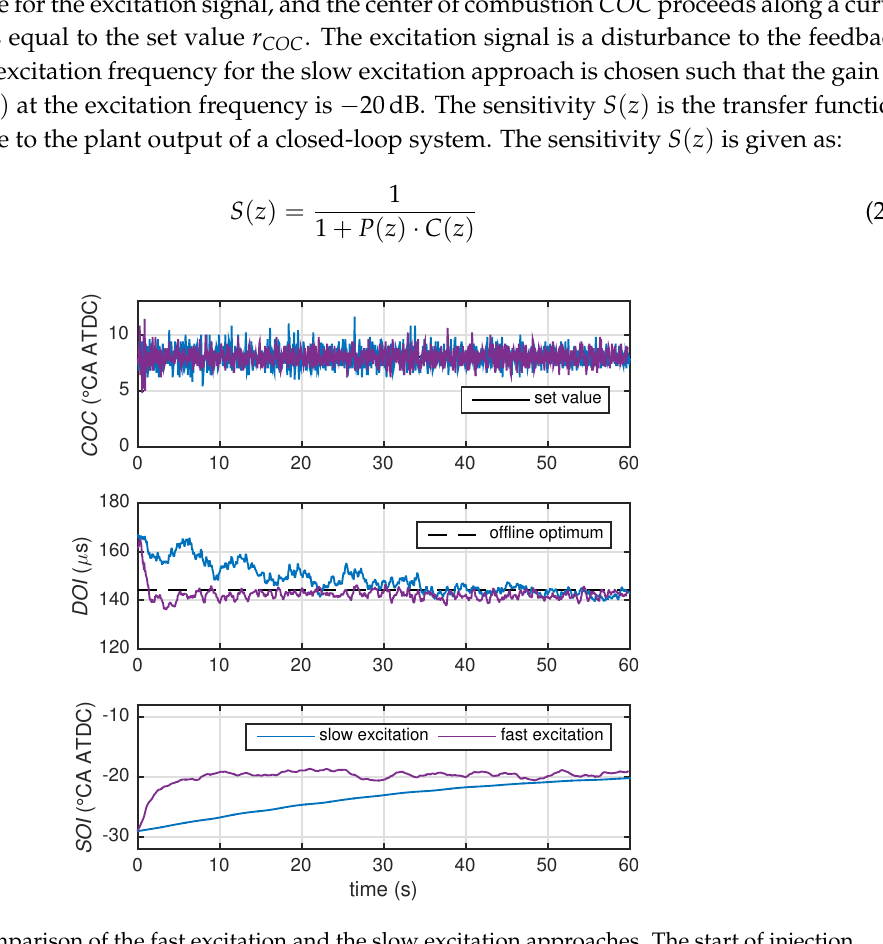
Figure 12. Comparison of the fast excitation and the slow excitation approaches. The start of injection SOI is initialized at − 29 ◦ CA ATDC. The start of injection SOI is shown without the excitation signal. The parameters of the low-pass filter LP ( z ) , the high-pass filter HP ( z ) , as well as the convergence rate (cid:101) are chosen analogously to the fast excitation approach in order to allow a fair comparison. For an analogous tuning with respect to the excitation frequencies, the fast excitation approach is able to reach the optimum in a shorter time period. The fact that the fast excitation approach converges faster than the slow excitation approach is due to the different orders of time scales (see Table